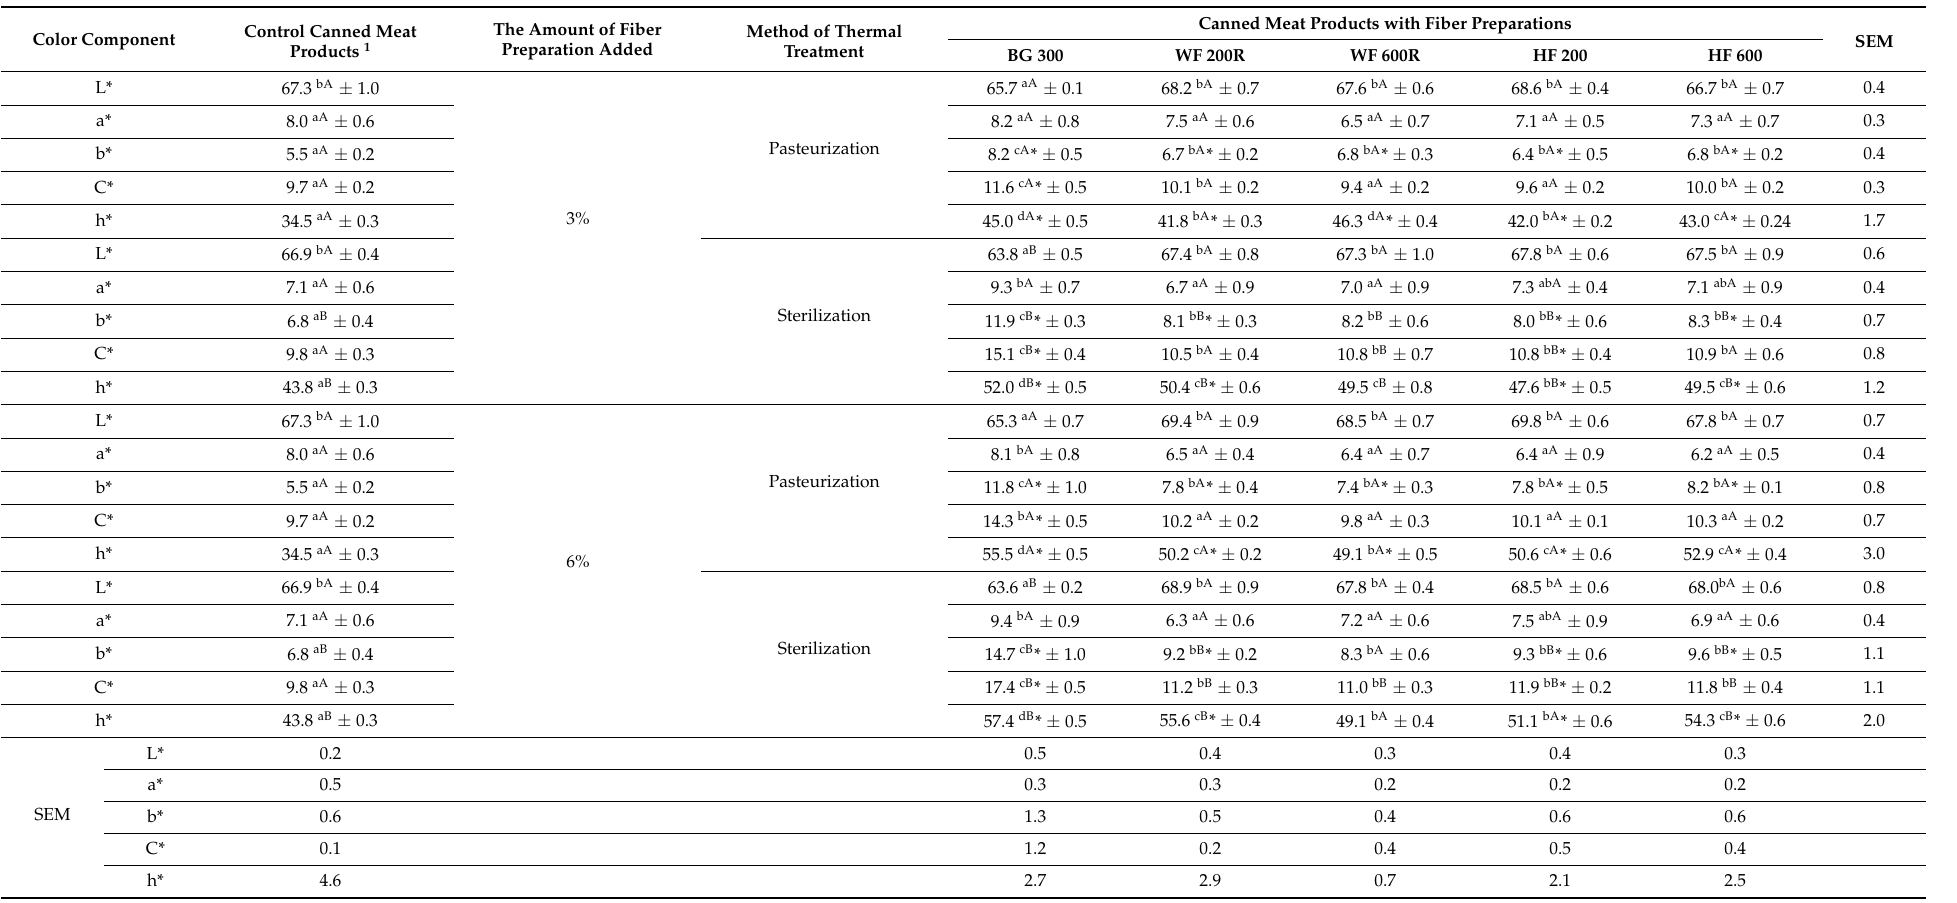
Table 2. L*, a* and b*, C* (Chroma) and h* (hue angle) color components of model medium-grounded pasteurized and sterilized model canned meat products (mean ± standard